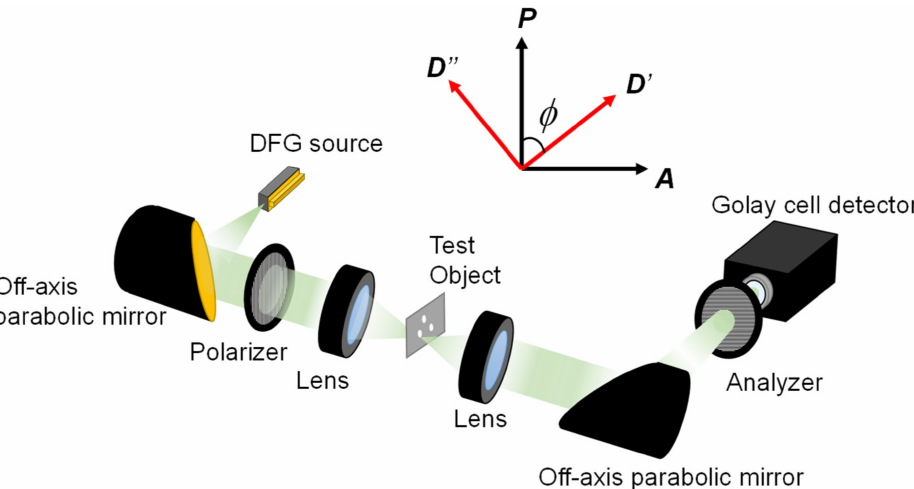
Figure 1. Schematic diagram of transmission imaging system based on THz DFG-source. The THz radiation from our device was reflected and collimated with an off-axis parabolic mirror ( f = 50 mm, 3-inch diameter) and was focused onto a test object by using an aspheric polymer lens ( f = 40 mm, 45 mm clear aperture; Tsurupica ® , Pax Co., Ltd., Sendai, Japan). Then, the THz beam transmitted through the object was collimated with another aspheric polymer lens (Tsurupica ® , f = 40 mm, 45 mm clear aperture) and was collected and coupled into a Golay-cell detector using another off- axis parabolic mirror ( f = 100 mm, 3 inch diameter). The inset shows the relationship between the polarizer axis ( P ), the analyzer axis ( A ) and the orientation of the liquid crystal polymer sample ( D (cid:48) is parallel to the molecular long axis, and D ” is perpendicular to the molecular long